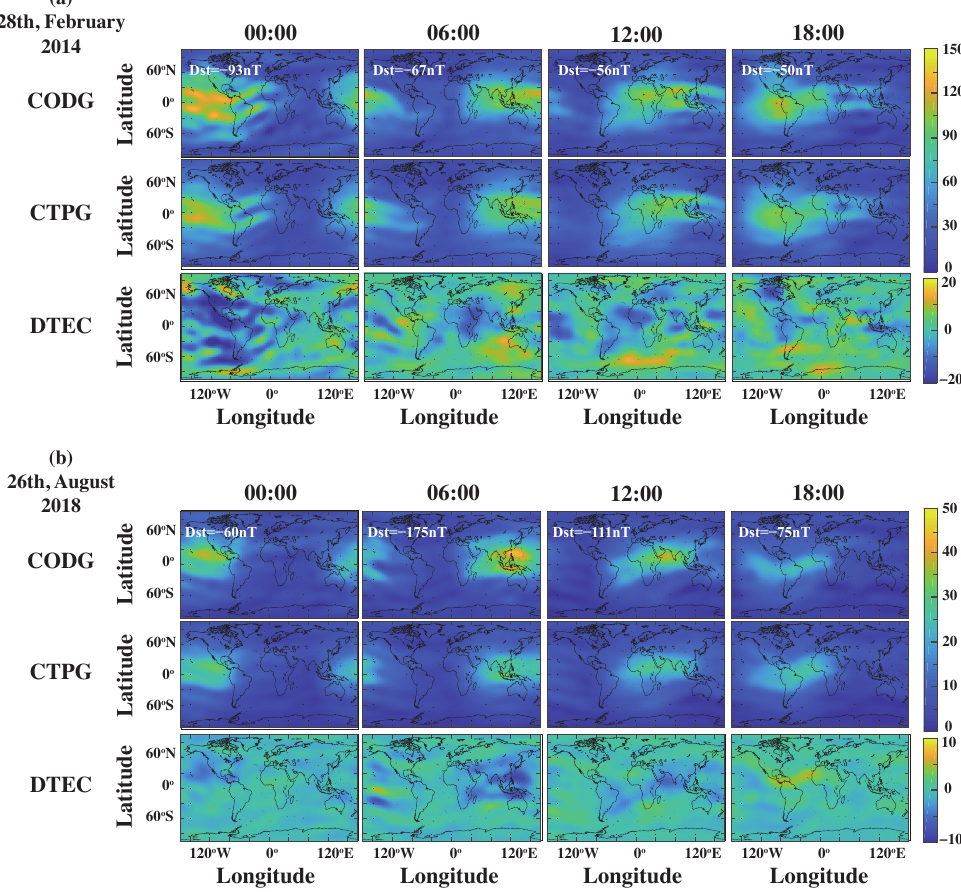
Figure 11. Comparison between the CTPG TEC maps and the CODE TEC maps at 00:00, 06:00, 12:00 and 18:00 UT on ( a ) 28 February 2014 and ( b ) 26 August